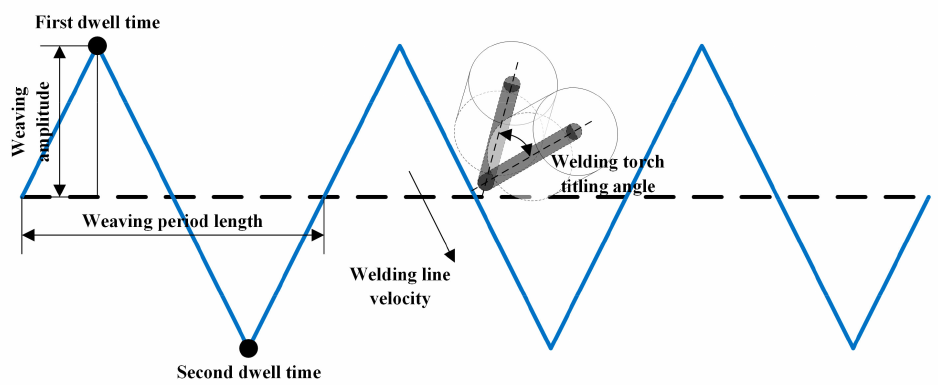
Figure 1. Weaving parameters of weaving